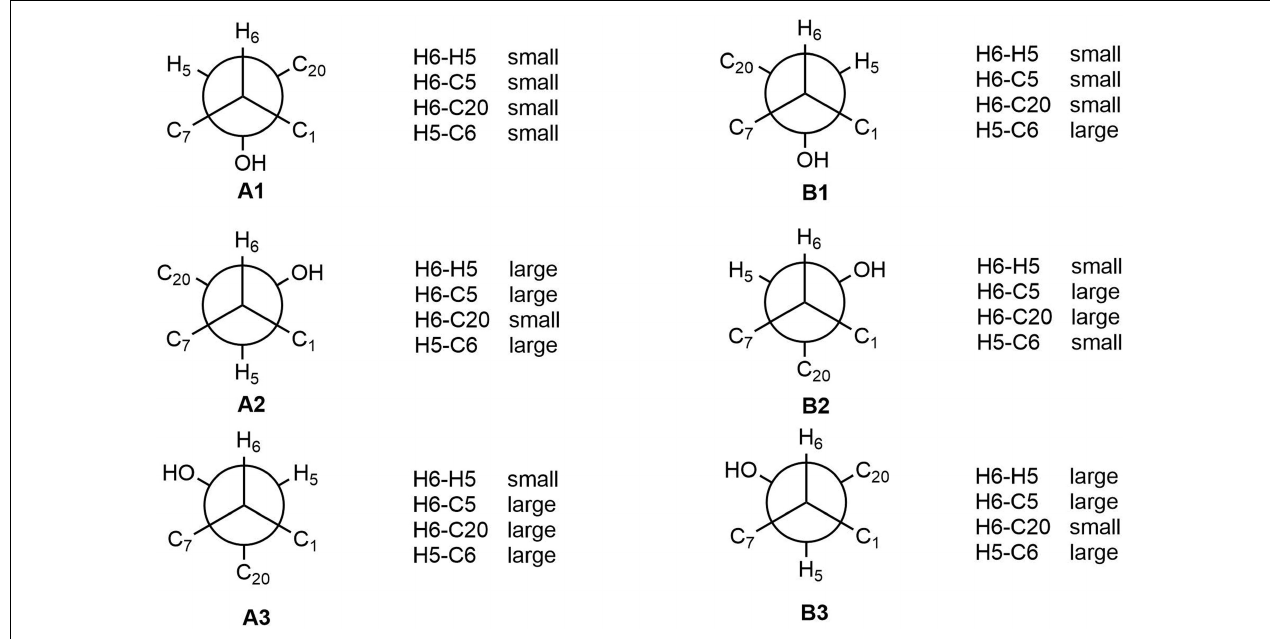
FIGURE 5 | J -Based analysis of six hypothetical rotamers with 5 R ,6 S (A1–A3) and 5 S ,6 S (B1–B3) configuration to determine the stereochemistry of 2 .